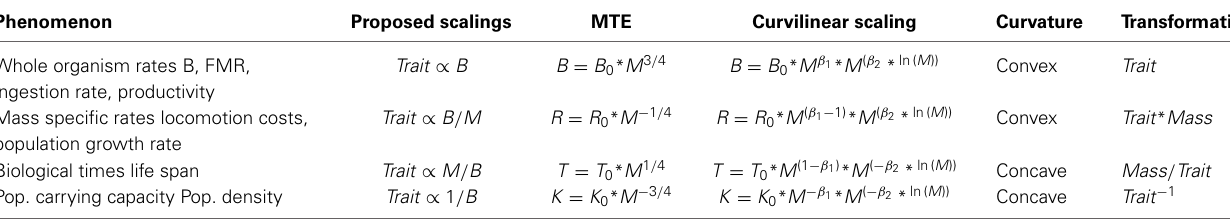
Table 1 | Body size and metabolic scaling for different ecological